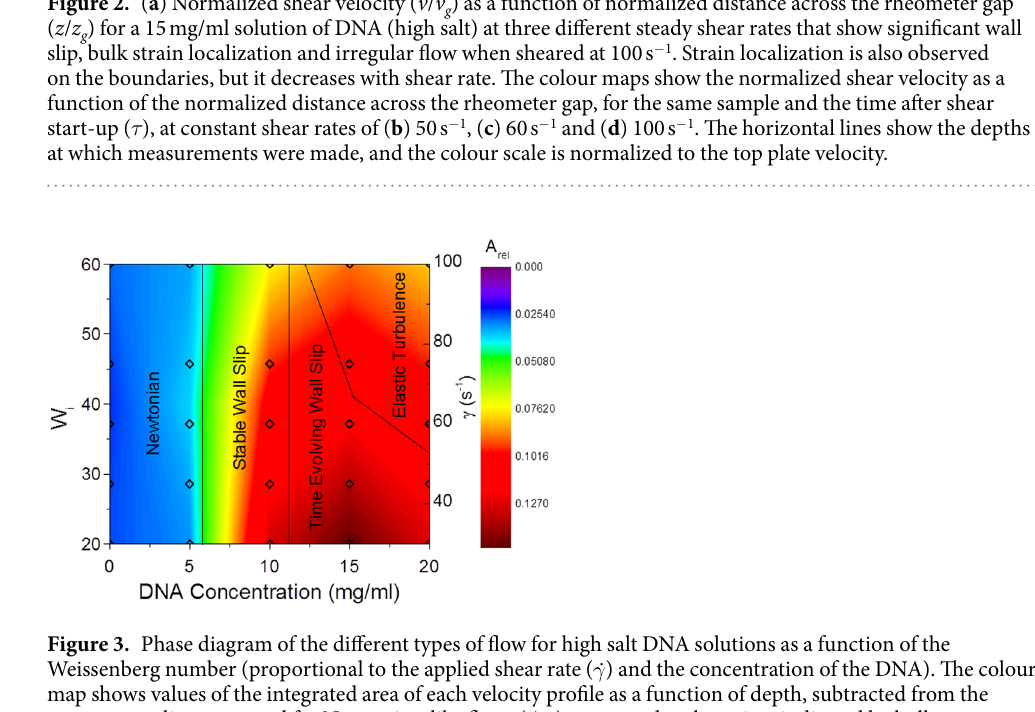
measured as a function of depth in the sample (Fig. 5a). At low DNA concentrations the velocity fluctuation amplitudes are fairly constant as a function of depth, whereas at higher DNA concentrations the amplitudes are lower near to the plates. By histogramming the measured velocity over long times, the distribution of velocities